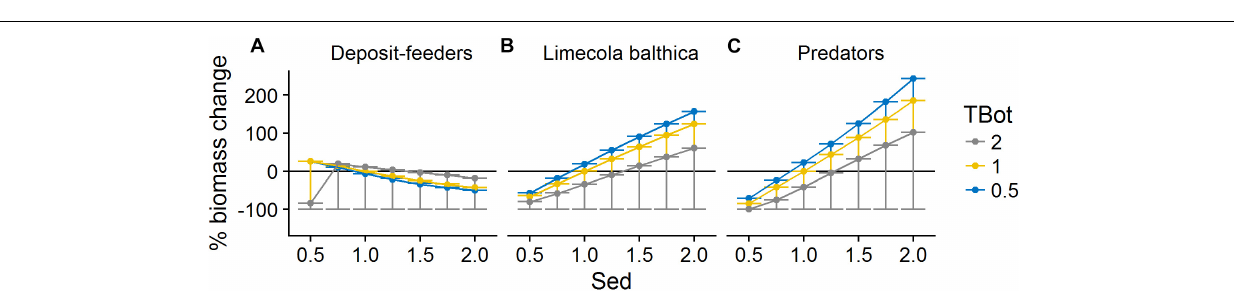
FIGURE 6 | Change in biomass of deposit-feeders (A) , L. balthica (B), and predators (C) as a function of relative changes in Sed and TBot, where 1 denotes baseline forcing. Biomass change is relative to baseline equilibrium value. Error bars show the variability in biomass change due to varying O2Conc. Horizontal line indicates no change. Forcing abbreviations are explained in Table 1